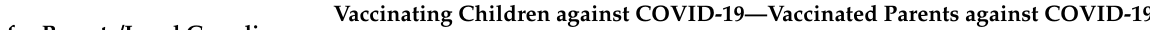
Table 8. The level of readiness of parents vaccinated against COVID-19 to vaccinate their own children.